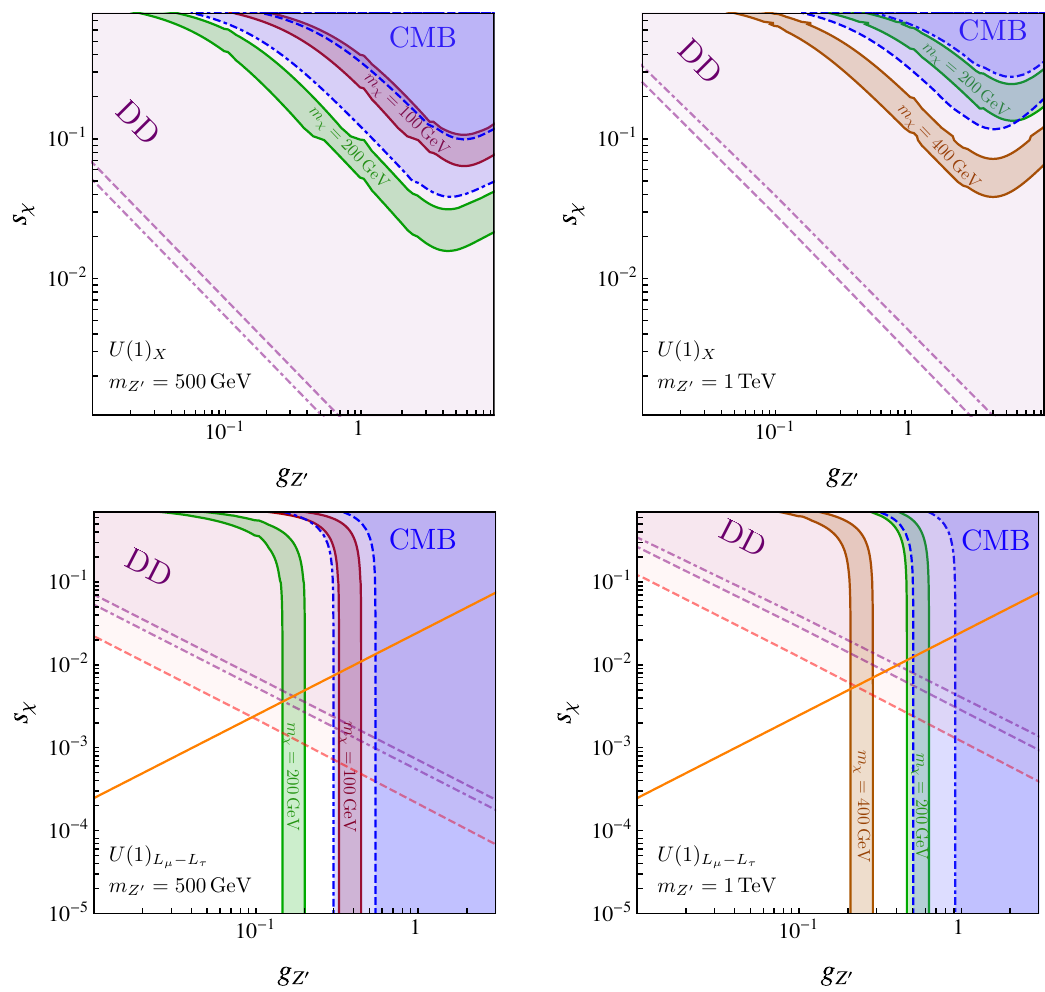
Figure 7: Constraints from the observed relic density in the U ( 1 ) (upper) and X = 500 GeV (left) with m = 100,200 GeV U ( 1 ) model (lower). We fix m χ L µ − L τ Z (cid:48) = 1 TeV (right) with m = 200,400 GeV. Indirect and direct detection con- or m χ Z (cid:48) straints are shaded. The (dot-) dashed contours correspond to m χ = ( 200 ) 100 GeV or m χ = ( 400 ) 200 GeV, respectively. The Xenon1T projection is indicated by the red dashed contour in the lower panels. The orange line indicates the purely loop- induced mixing angle for a given g Z (cid:48)